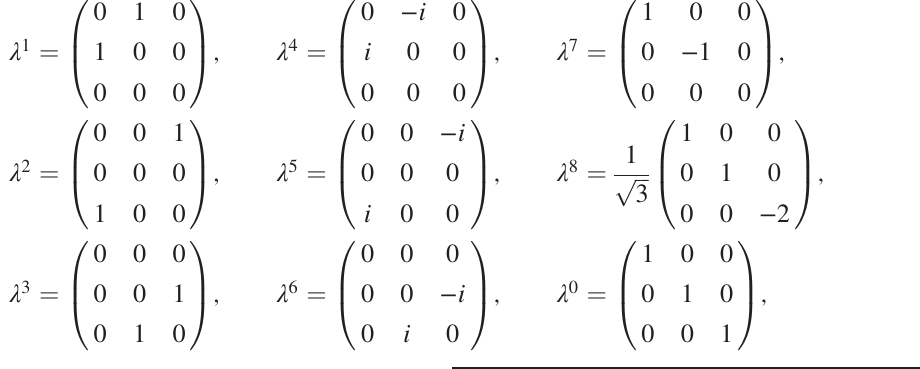
sponding to the symmetric interorbital fluctuations λ 1 , λ 2 , and λ 3 are identical to each other. Similarly, the order parameters corresponding to the antisymmetric interorbital fluctuations λ 4 , λ 5 , and λ 6 are identical to each